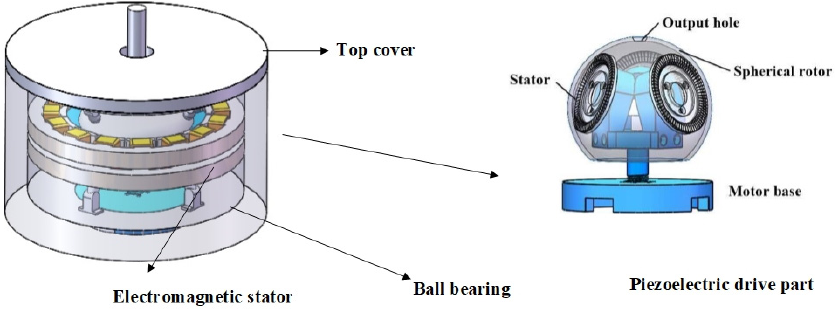
Figure 1. Hybrid drive structure.